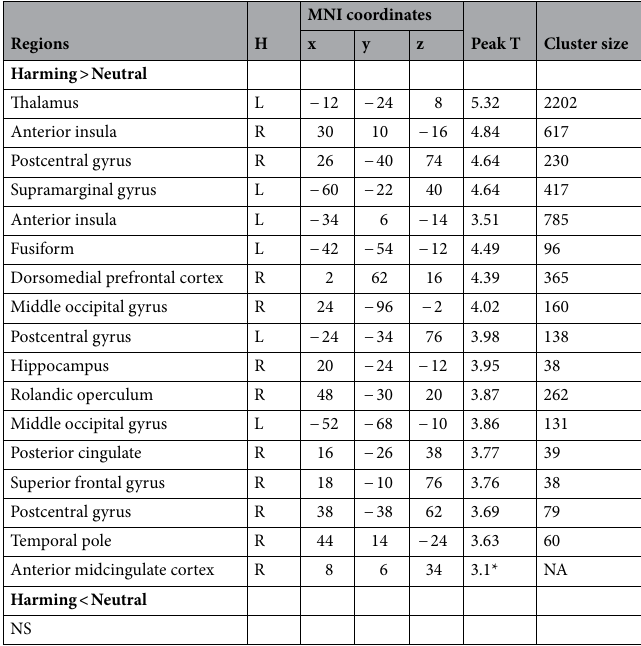
Table 3. Neural Activations (harming vs. neutral) during the virtual obedience paradigm. Pooled group results (N = 56). All reported clusters significant at the FWE-corrected P < .05 level unless marked with an asterisk, which were taken from pre-defined regions of interest (ROIs) and significant at uncorrected P < .05. H, hemisphere; MNI, Montreal Neurological